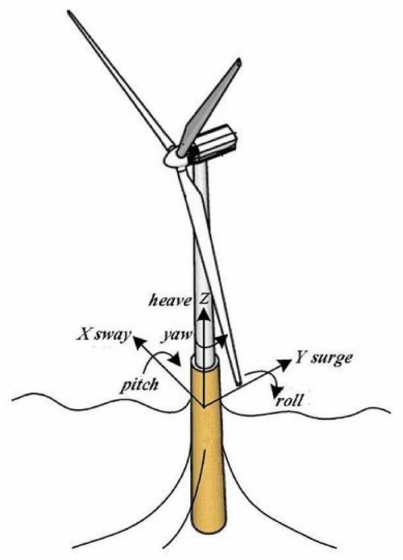
Figure 1. 6-DOF motions of a wind turbine floating